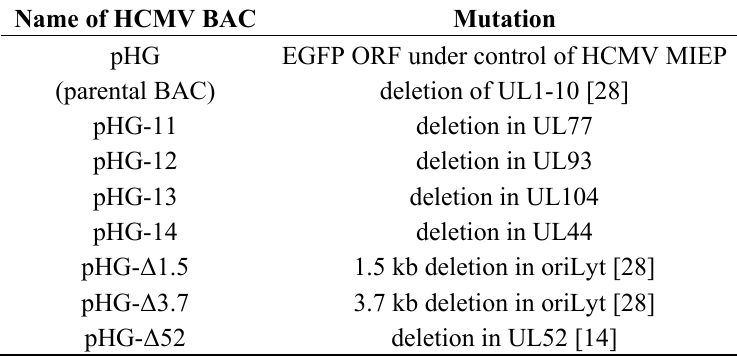
Table 1. HCMV BACs used in this